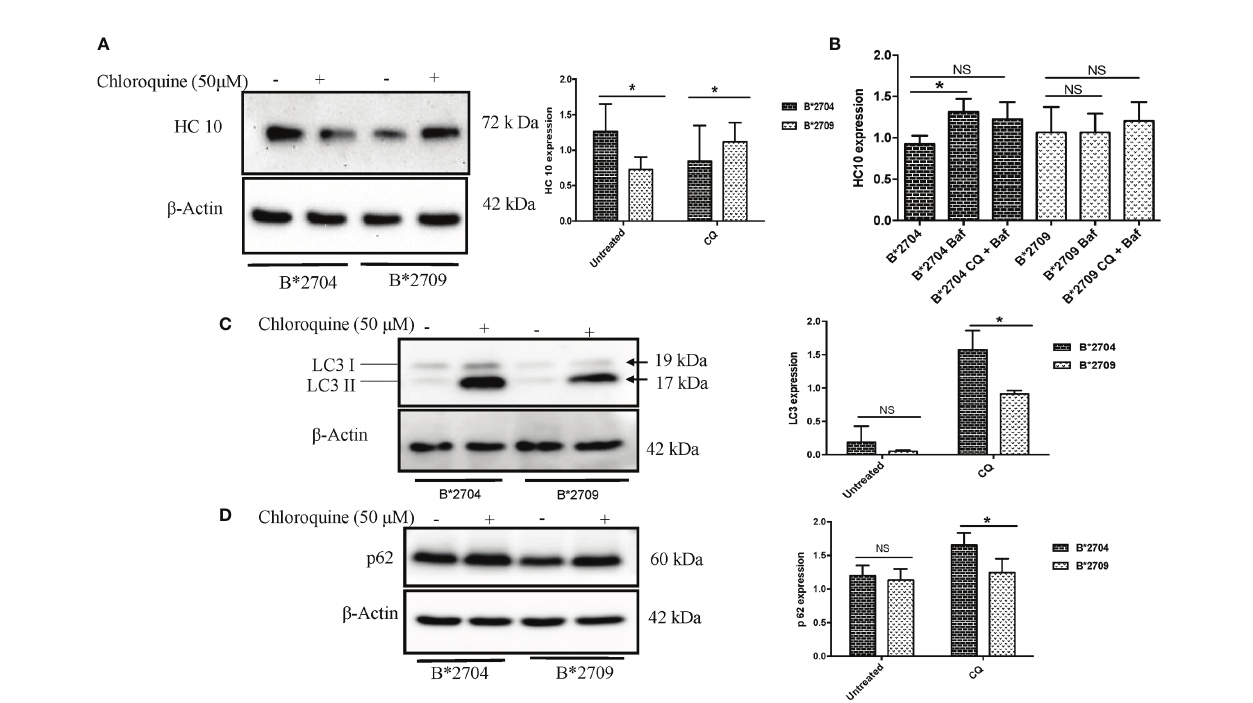
FIGURE 3 | Stable transfectants of pEGFP-HLA-B27 subtypes (B*2704 and B*2709), in the absence (untreated) or presence of CQ, were probed with HC10 antibody (A) and also treated with Baf and Baf+CQ (B) for detection of heavy chains. Expression levels of autophagy markers LC3 (C) and p62 (D) were evaluated. Western blotting was done, and actin levels were probed to serve as loading control for all samples to allow normalization of the signals. In each panel, histograms show densitometry data (mean ± SD) from 3 experiments corresponding to the Western blotting, using ImageJ software. Baf, ba fi lomycin; CQ, chloroquine. NS, non signi fi cant (p > 0.05); *p <